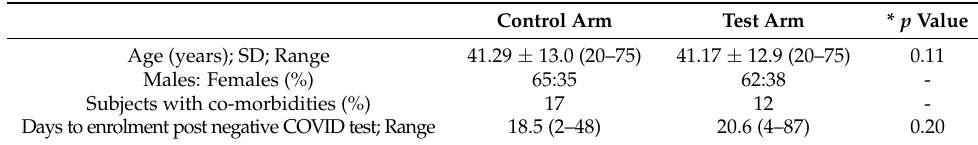
Table 2. Demographics and baseline